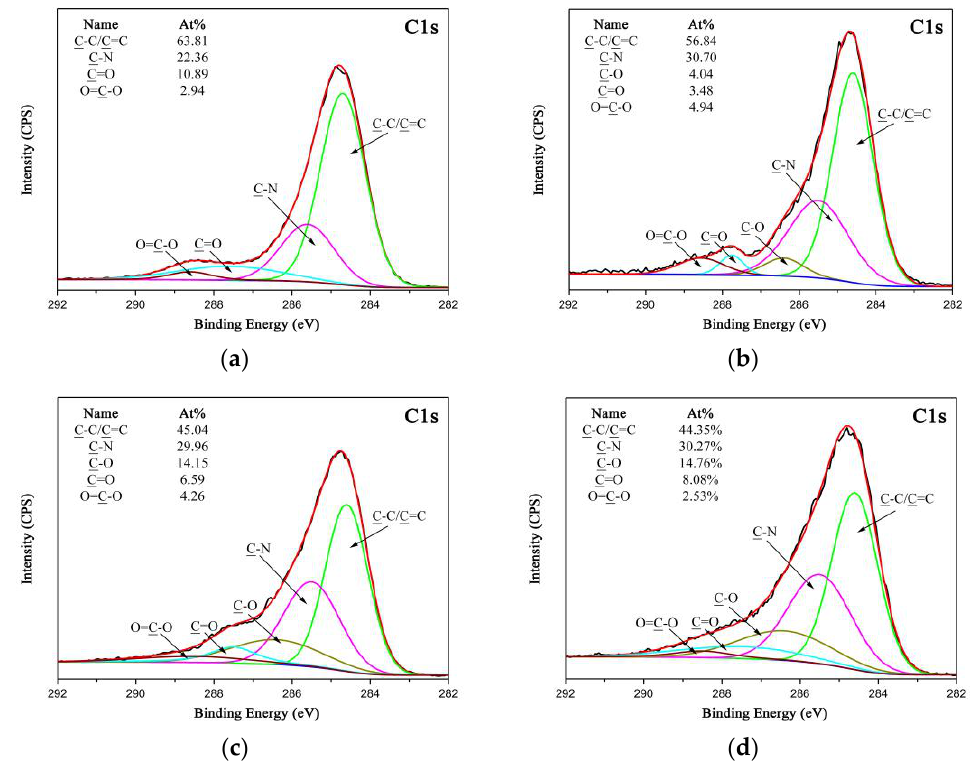
Figure 6. High-resolution C 1s XPS spectra of PPTA surface: ( a ) A-PPTA; ( b ) PPTA-3; ( c ) PPTA-4; ( d ) PPTA-5.